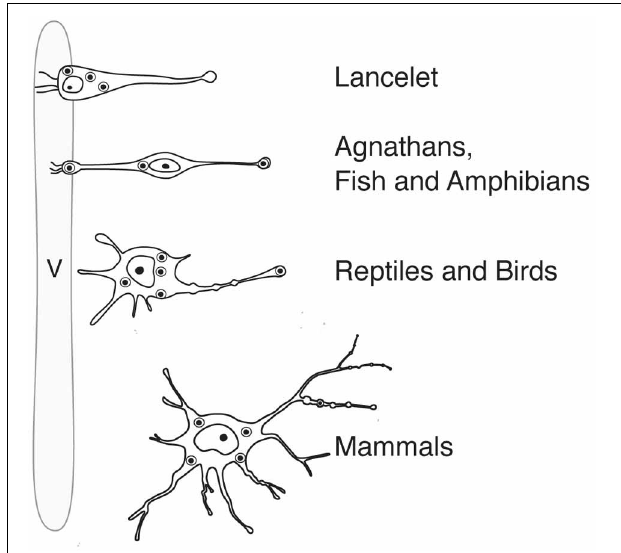
FIGURE 2 | Anatomy and position (in relation to the lumen of the ventricle) of magnocellular neurosecretory neurons in the hypothalamus of representatives of the phylogenetic tree. v, ventricle.